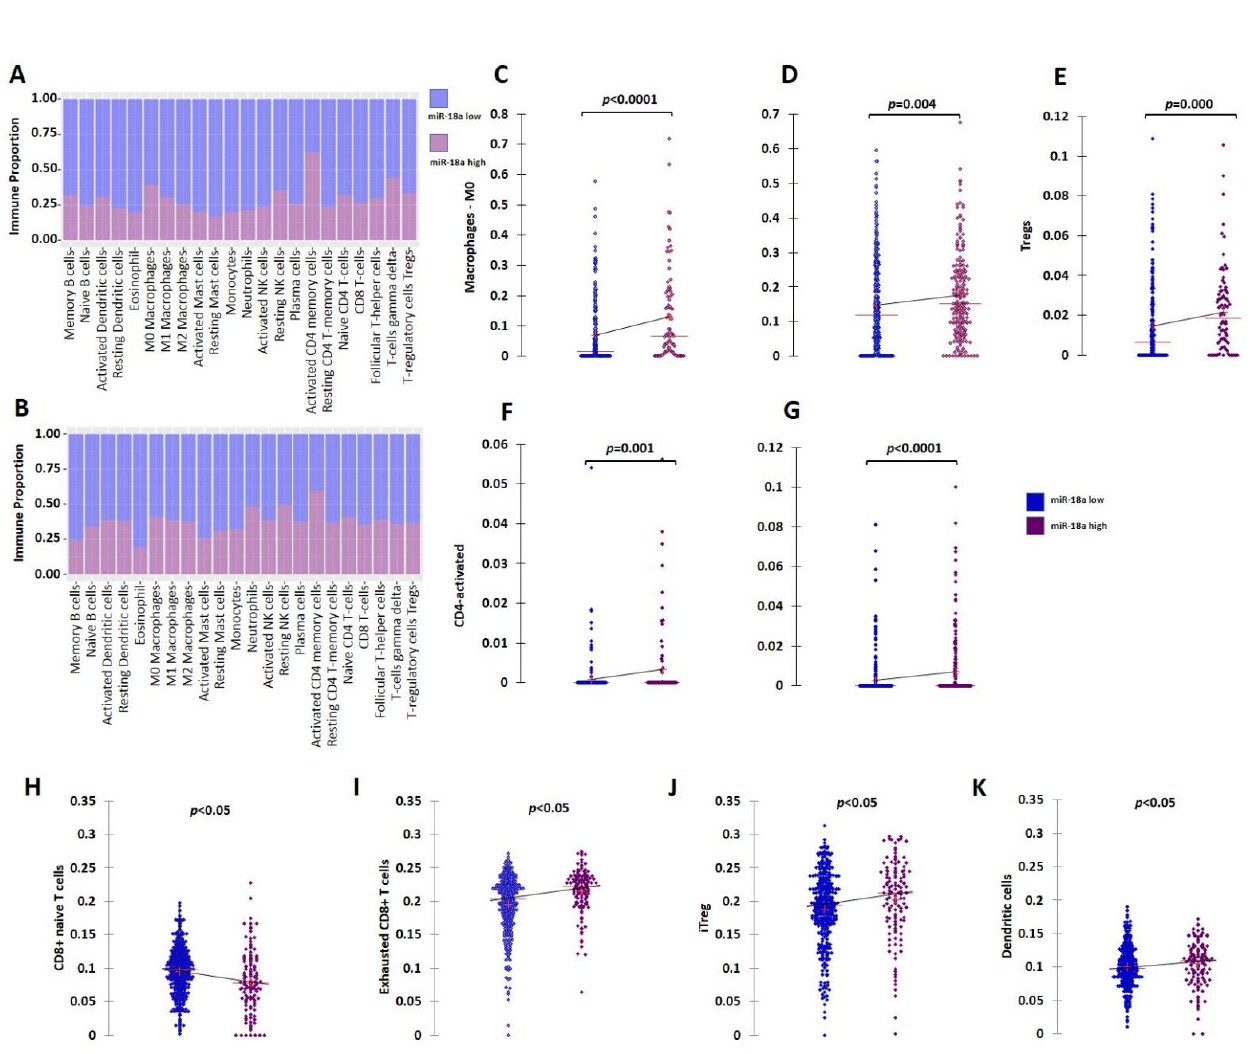
Figure 2. Analysis of immune cell proportions in ER+ miR-18a high- vs. low-expressing tumors. ( A ) Proportion plot after CIBERSORT analysis depicting immune cell proportions in ER+ tumors of the TCGA cohort ( n = 333) segregated based on upper and lower quartiles of miR-18a expression. ( B ) Proportion plot after CIBERSORT analysis depicting immune cell proportions in ER+ tumors of the METABRIC cohort ( n = 506) segregated based on upper and lower quartiles of miR-18a expression. ( C ) Scattergrams depicting associations between proportions of M0 macrophages and ER+ tumor groups of TCGA and ( D ) METABRIC segregated based on upper and lower quartiles of miR-18a expression as analyzed by CIBERSORT. ( E ) Scattergrams depicting associations between proportions of Tregs and ER+ tumor groups of TCGA. ( F ) Scattergrams depicting associations between proportions of CD4 activated cells and ER+ tumor groups of TCGA and ( G ) METABRIC. ( H – K ) Scattergrams depicting associations between immune cell type proportions and ER+ tumor groups of TCGA segregated based on upper and lower quartiles of miR-18a expression as analyzed by ImmuneCellAI. Statistical analysis was performed by Mann – Whitney U test. p < 0.05 is considered significant.